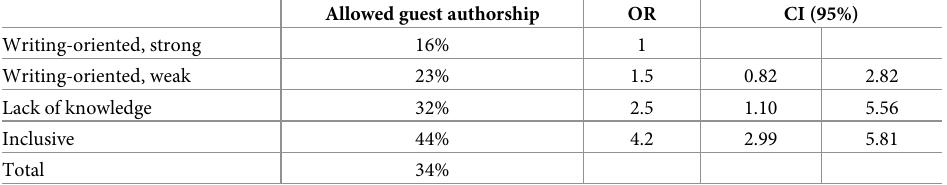
Table 16. Share granting a guest authorship to a person in power at least once across the four classes. ( n =